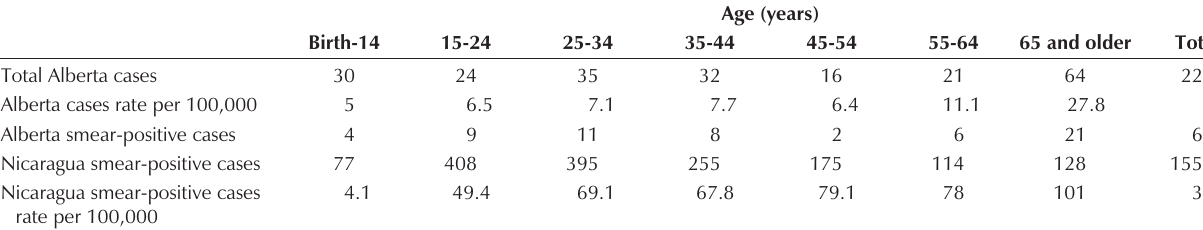
Age-specific total of Alberta and smear-positive Alberta and Nicaragua tuberculosis cases in 1992